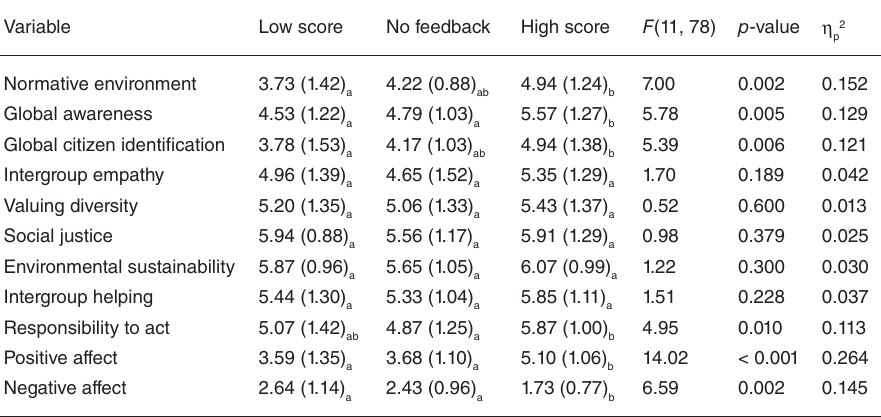
Table 2: Means (standard deviations) by feedback condition, Study 2 Variable